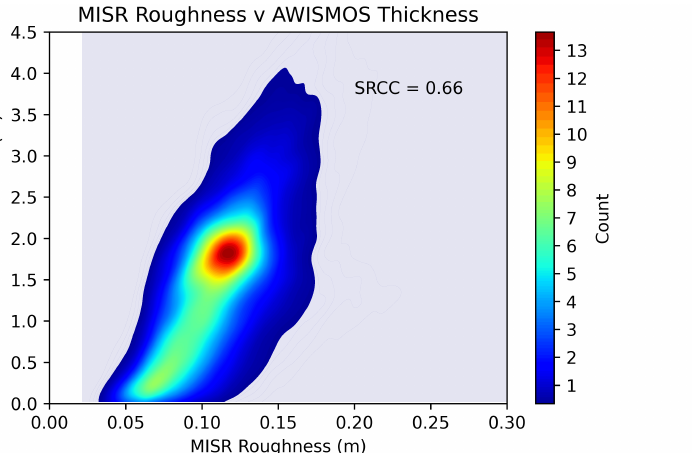
Figure 12. Two-dimensional scatter plot shows a bivariate distribution between MISR-derived roughness (m) and AWI CS-2 SMOS merged thickness (m) for 01–15 April 2011–2020 and 25 km resolution. Count density refers to measurements over a 300 300 grid over the presented range × (per 1.5 cm of thickness and per mm of roughness). The opaque shaded region represents 95% of the range, contours for the remaining percentiles are at single increments, and the valid bounds in light blue. Spearman’s rank correlation coefficient (SRCC) between derived MISR roughness and AWI CS-2 SMOS thickness is 0.66 ( p <